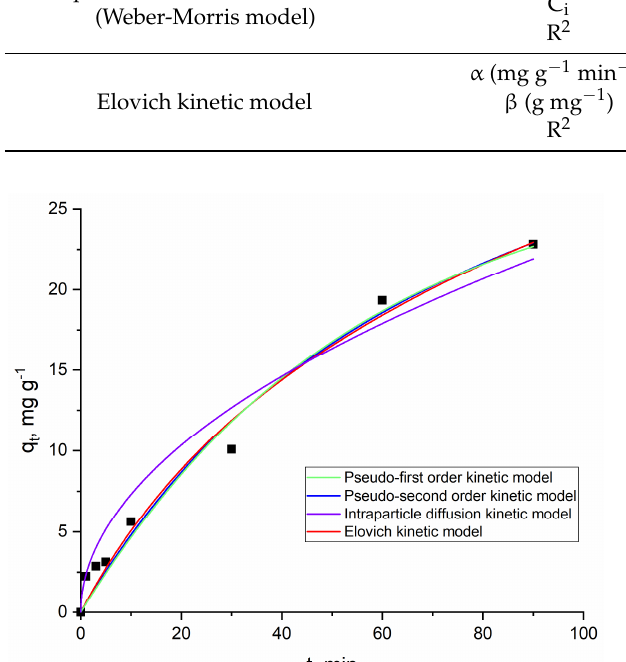
Pseudo-second order kinetic model